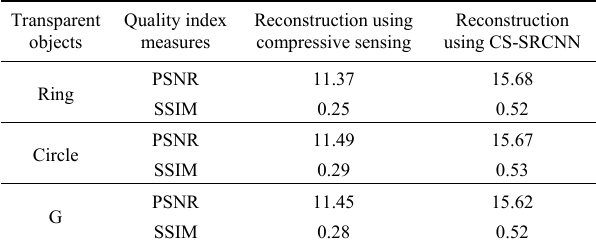
values. Table 1 indicates the image quality of each object. Table 1 Image quality